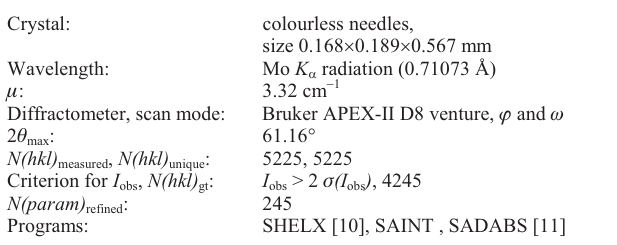
Table 1. Data collection and handling.